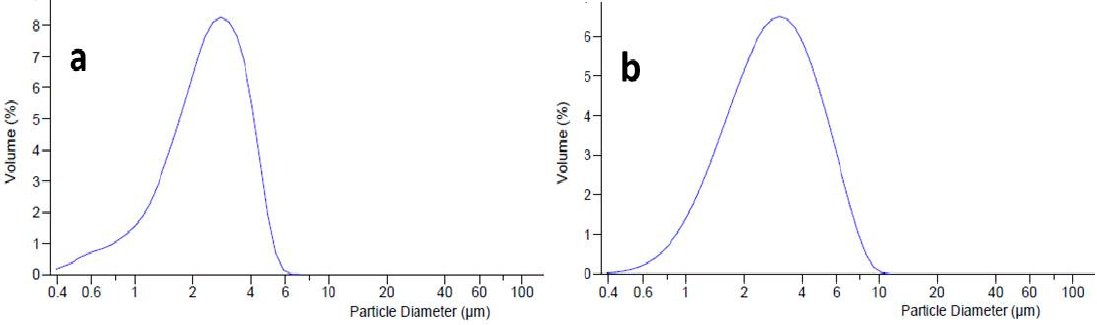
Figure 5. Dimensional distribution curve of L-blank emulgel ( a ) and L-MTE-mp emulgel ( b ).